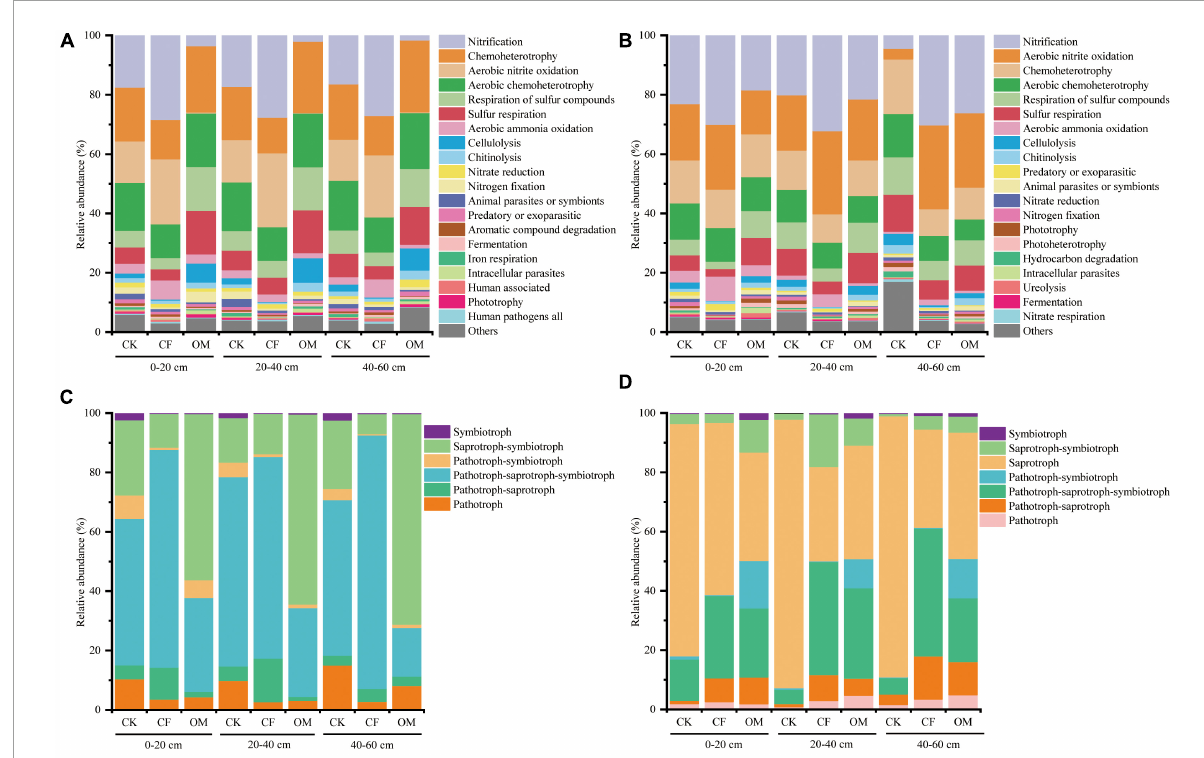
FIGURE5 The relative abundance of dominant bacterial (A,B) and fungal (C,D) functional groups based on Functional Annotation of Prokaryotic Taxa (FAPROTAX) and FUNGuild. The left column is the samples in the year of 2019, and right column is in the year of 2020. CK, no fertilization; CF, chemical fertilization; OM, organic